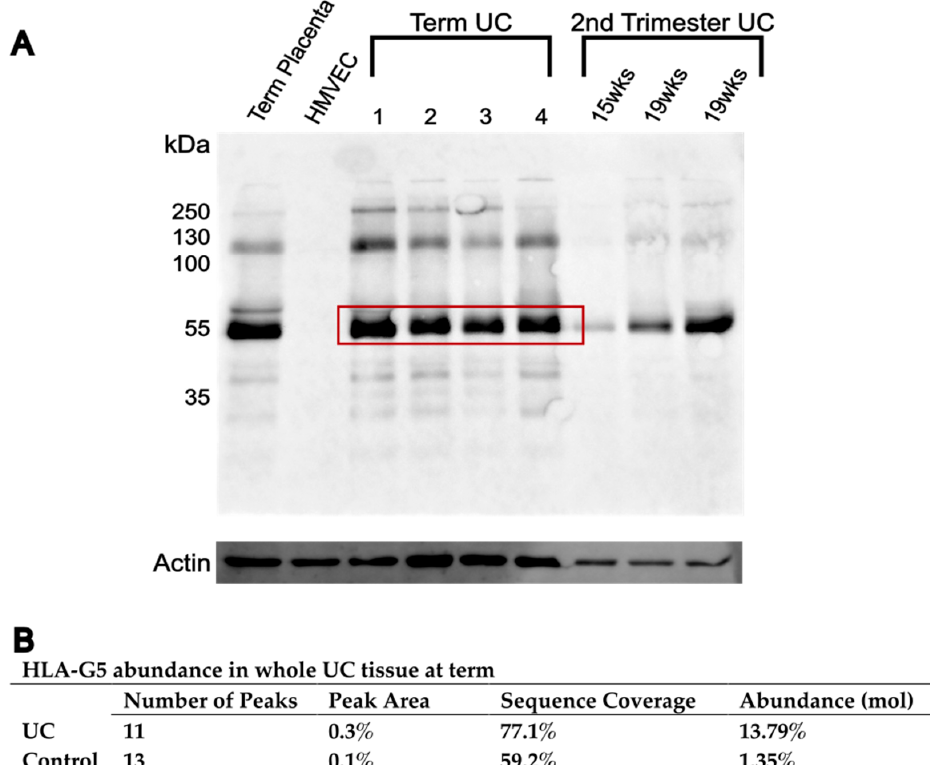
Figure 7. Investigation of HLA-G presence in whole UC tissue. ( A ) Western immunoblotting of whole UC tissue lysate using samples at term ( n = 4) and in early pregnancy ( n = 3). Term placental tissue lysate was used as the positive control, and primary human microvascular endothelial cell (HMVEC) lysate was used as the negative control. Actin was used as the housekeeping protein. ( B ) Mass spectrometry analysis of HLA-G in a whole UC tissue at term (from boxed region in ( A )) revealed a low abundance of HLA-G5. A blank area of the gel was used as negative control.